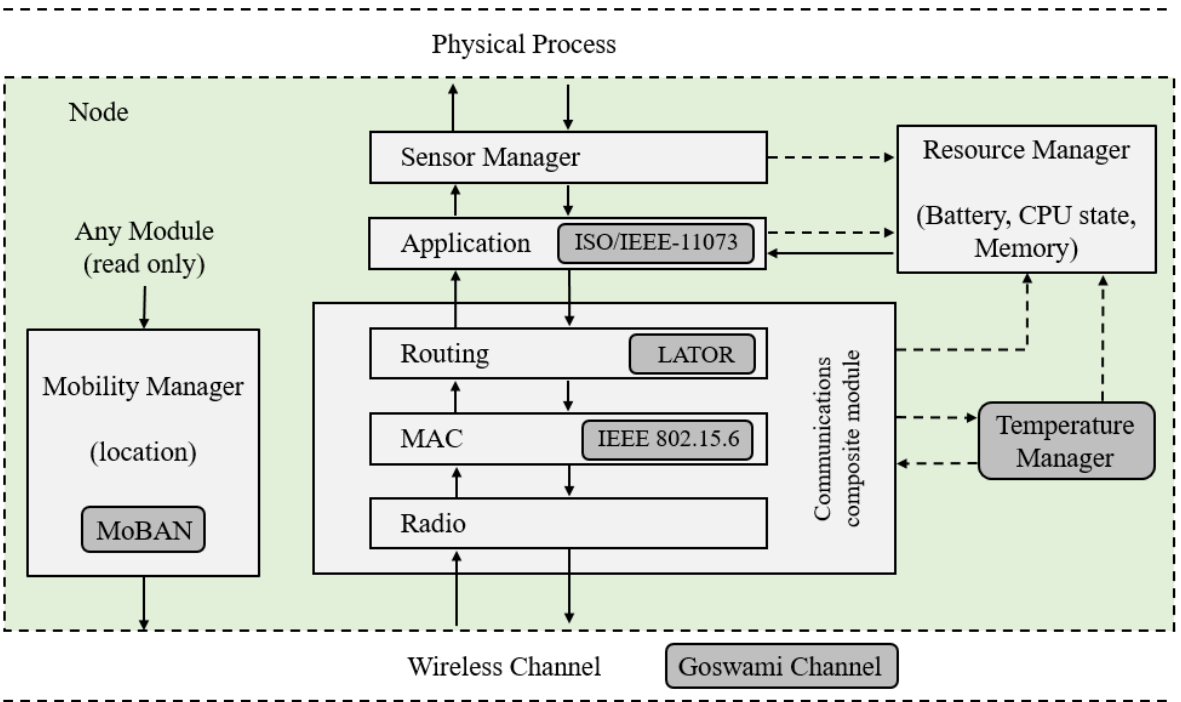
Figure 1. The BNS framework